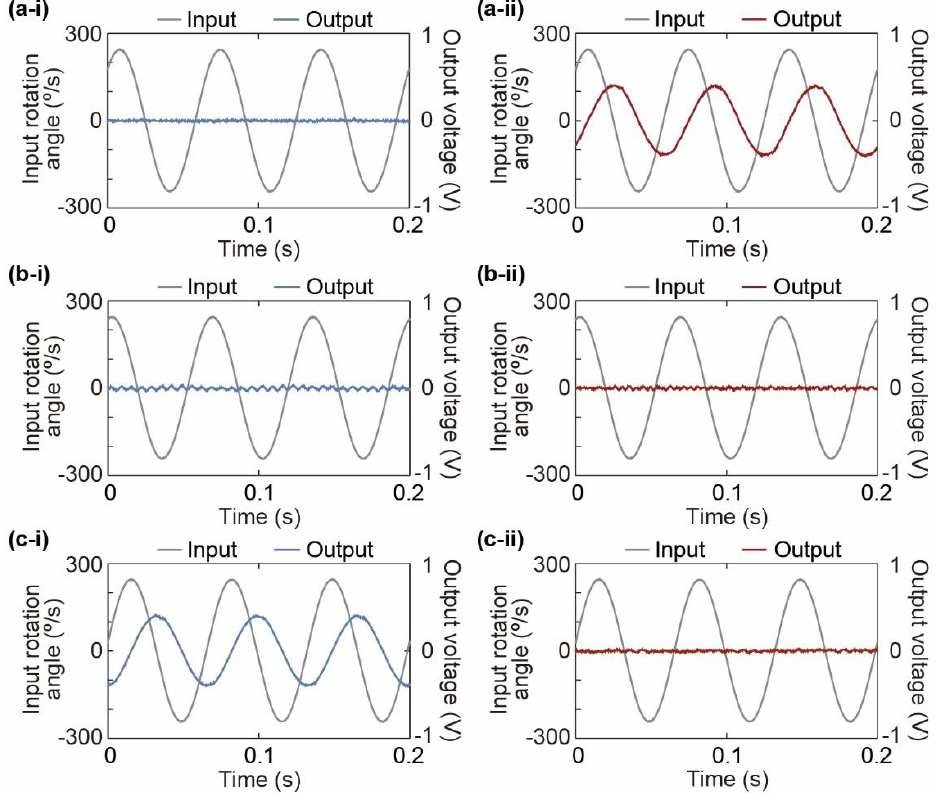
Figure 9. Input rotation angle of the turntable and output voltage of the sensor at 15 Hz. ( a ) z -axis direction of the proposed device, ( b ) x -axis direction of the proposed device, and ( c ) y -axis direction of the proposed device. ( i ) Sensor unit 1 and ( ii ) sensor unit 2.